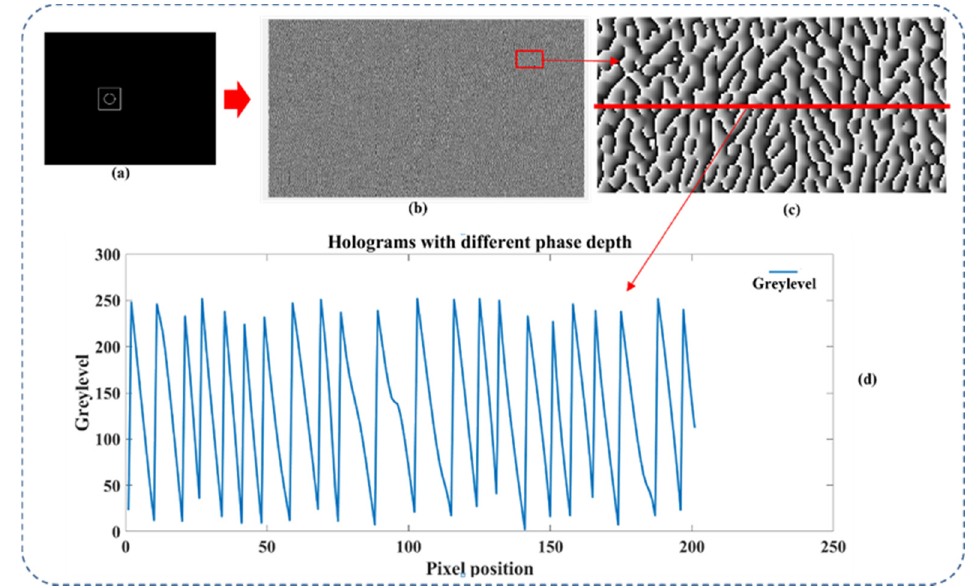
Figure 5. The partial phase profile of the hologram with three different grey levels displayed on the active area of an LCOS SLM: a target image ( a ), the corresponding CGH hologram ( b ), a selected area of the hologram ( c ), and the grey levels ( d